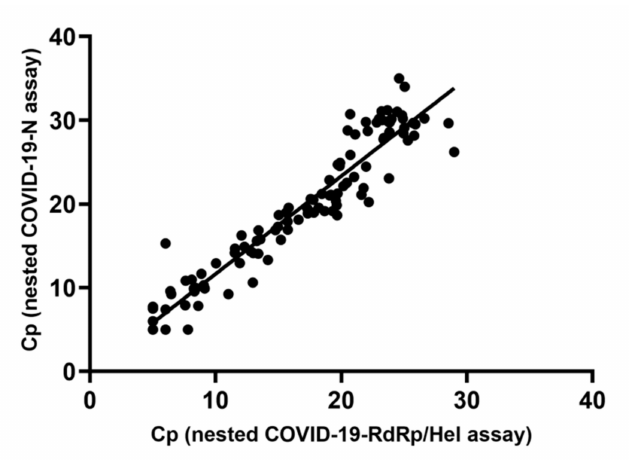
Figure 1. Correlation of the Cp values of the specimens found positive for SARS-CoV-2 by the STN COVID-19-RdRp / Hel assay and the STN COVID-19-N assay.